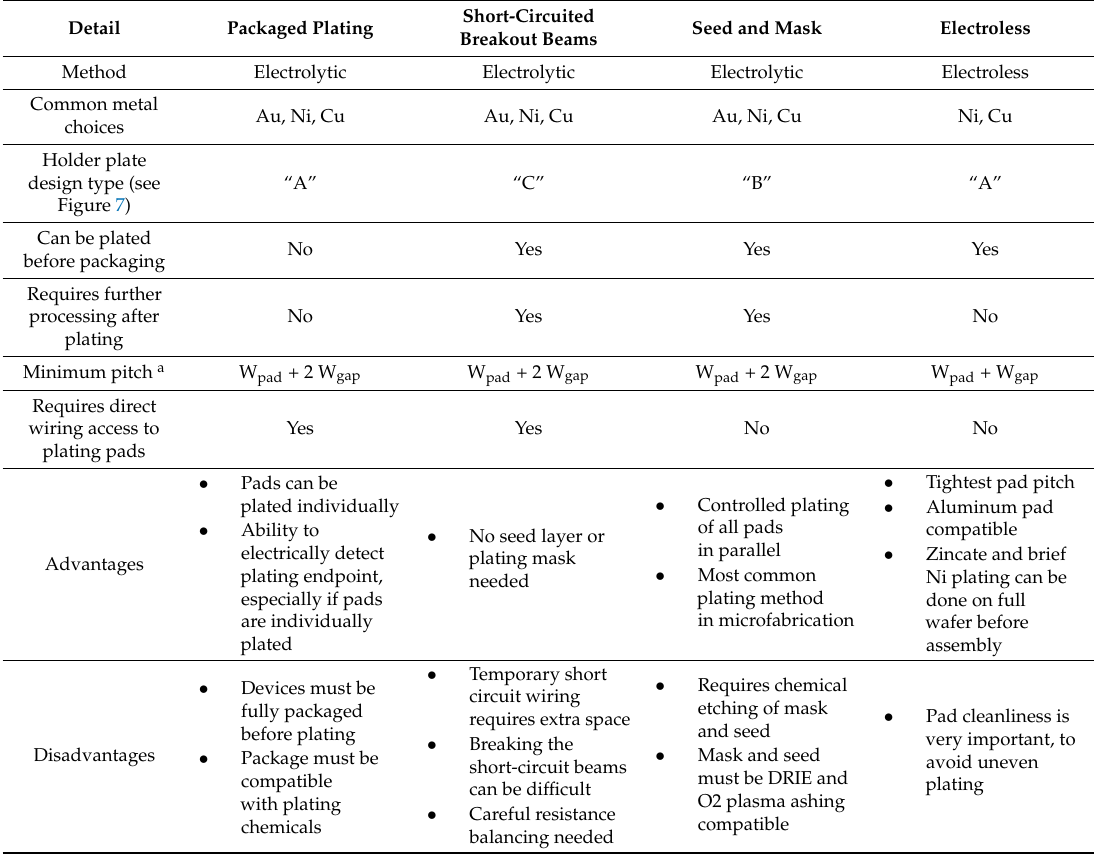
Table 3. Comparison of Electroplating